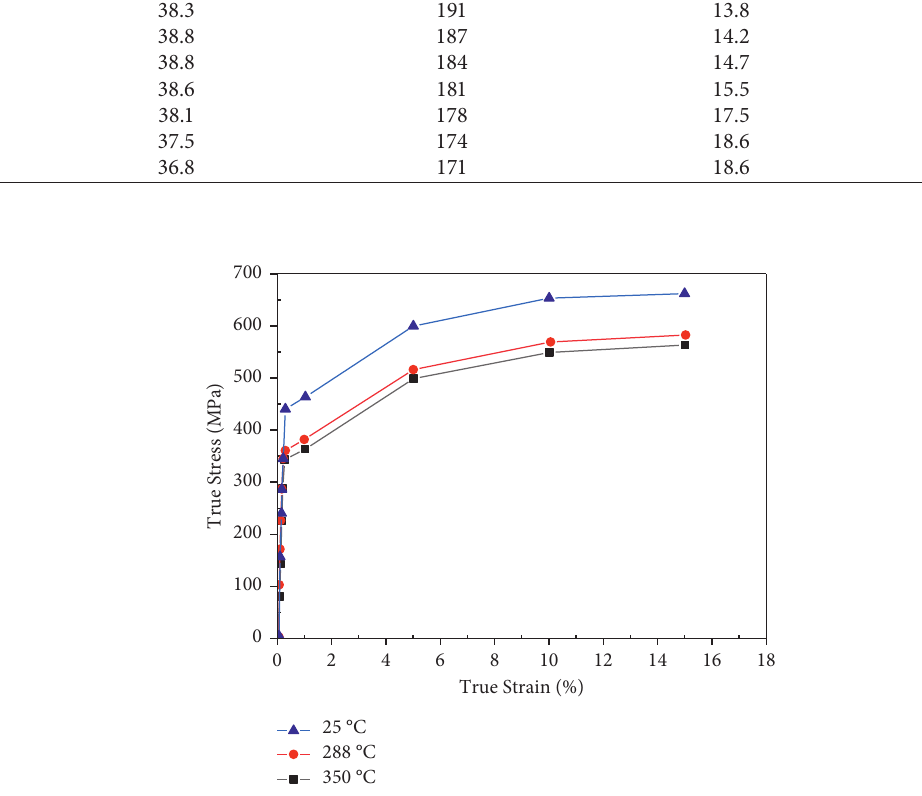
Figure 1: True stress-strain characteristics of the RPV’s steel at different temperatures.